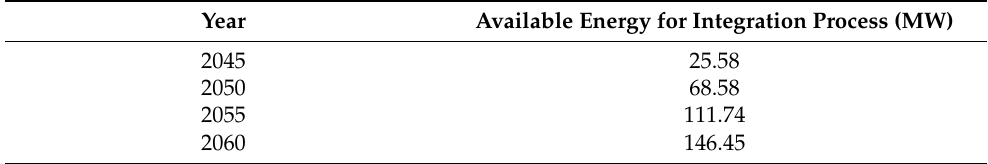
Table 13. Available energy from hydrogen LOHC